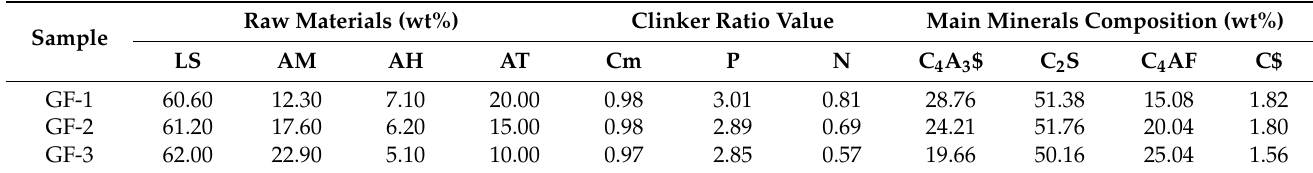
Table 2. The mix design of the raw materials, theoretical clinker ratio value, and calculated mineral composition of the BBSC